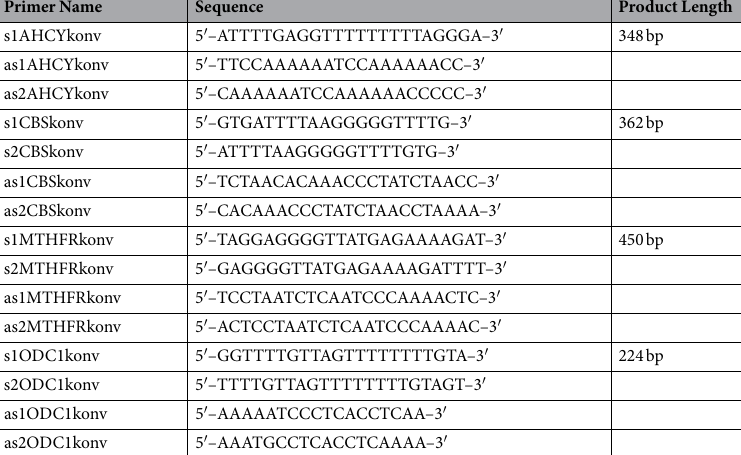
Table 2. Primers used for bisulfite genomic sequencing.